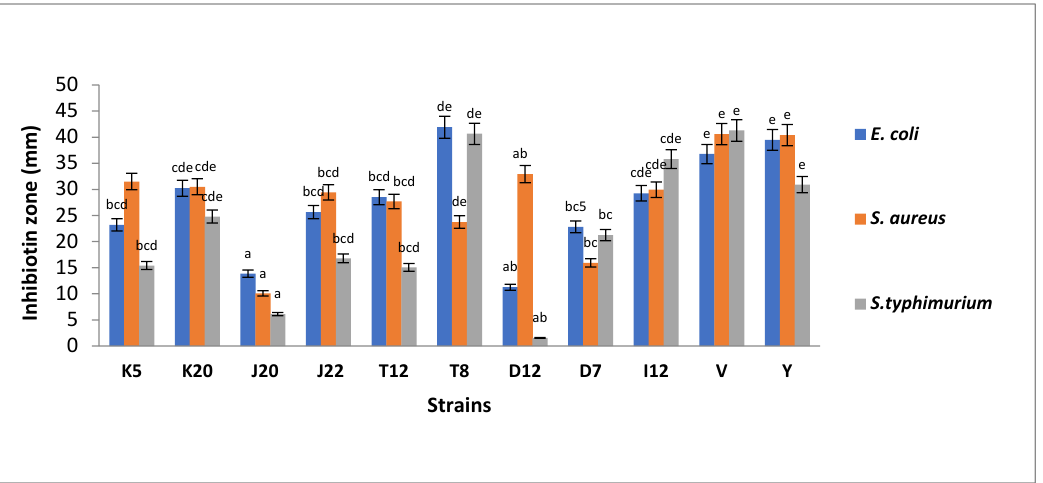
Figure 1. The antibacterial activity of LAB strains against pathogenic E. coli ATCC 8739, S. aureus ATCC 6538 and S. typhimurium ATCC 14028. Each bar represents mean of duplicate determinations (n = 2). Mean values with same letter/s are not significantly different ( p ˃ 0.05). Isolate codes (K5, K20, J20, J22, T12, T8, D12, D7 and I12) represented by single letter and number indicate the strain number where the strains were isolated.